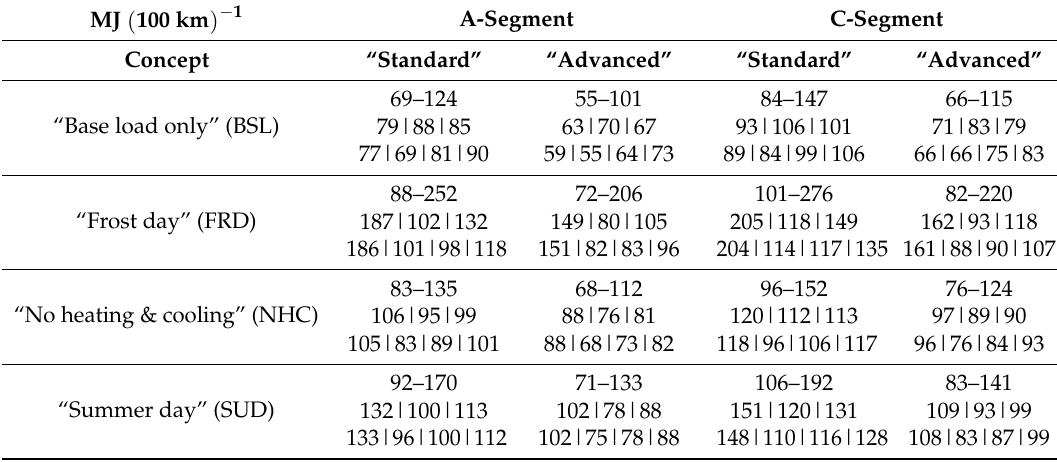
Table A7. Fuel economy figures of an FCV considering different load cases and drive cycles. First line: Range of results for all 25 drive cycles. Second line: Values for ECE|EUDC|MVEG; Third line: Values for WLTC-Low|WLTC-Middle|WLTC-High|WLTC-Very